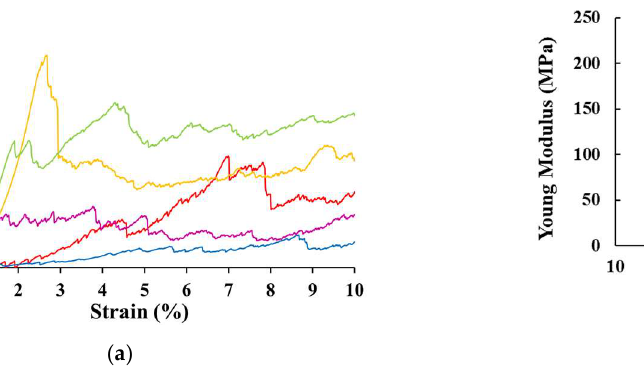
Figure 5. ( a ) Stress–strain curves of some 3D-printed carbon studied in this work. ( b ) Young modulus as a function of the initial HDDA content.